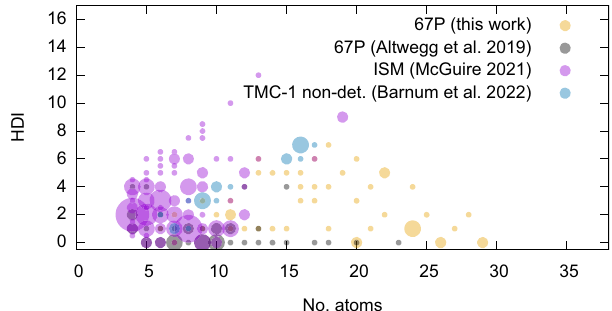
Fig. 3 Comparison of the cometary ensemble to the Interstellar Medium (ISM). C-bearing neutrals, composed of four atoms or more, identi fi ed in the coma of comet 67P previously (Ref. 1 grey) or newly in this work (yellow) are compared to those detected in the ISM (Ref. 60 ; purple). Furthermore, non-detection (non-det.) of a series of heterocycles in the Taurus Molecular Cloud 1 (TMC-1) are included (Ref. 65 ; blue). The molecules ’ hydrogen de fi ciency index (HDI) values are plotted as a function of the number of constituting atoms (no. atoms). The size of the circles represents the number of molecules sharing HDI value and number of atoms (the smallest circles correspond to one